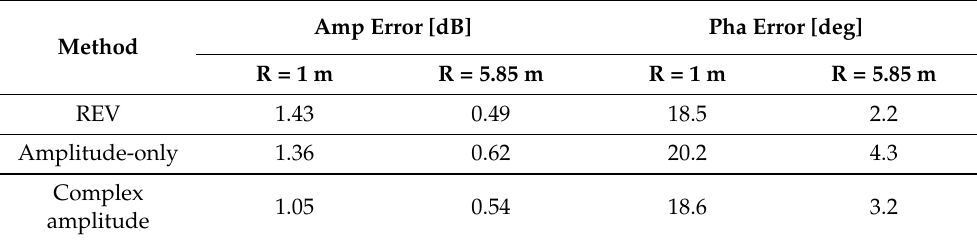
Figure 15. The calibration errors for the 4 × 8 URA and the centered 4 × 4 URA with method 3. Table 1. The Comparison of The Peak Error of The Three Calibration